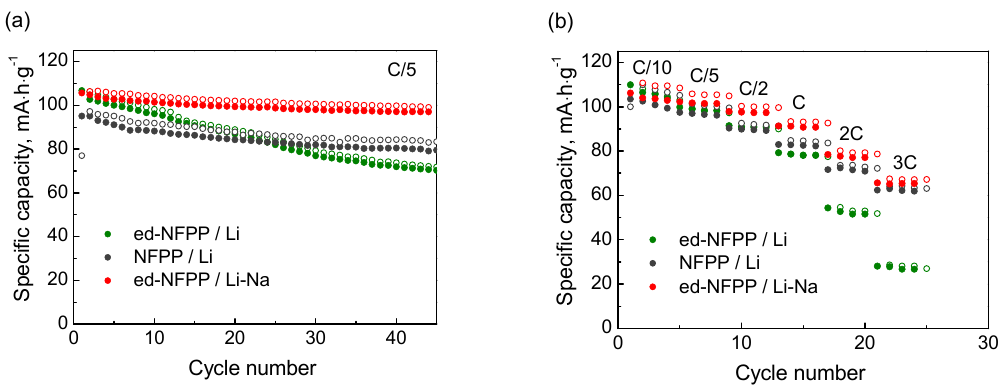
Figure 3. Charge-discharge capacity vs. cycle number (at the C / 5 cycling rate) ( a ) and cycling discharge rate ( b ) for three electrochemical cells: NFPP / Li, ed-NFPP / Li-Na and ed-NFPP / Li.